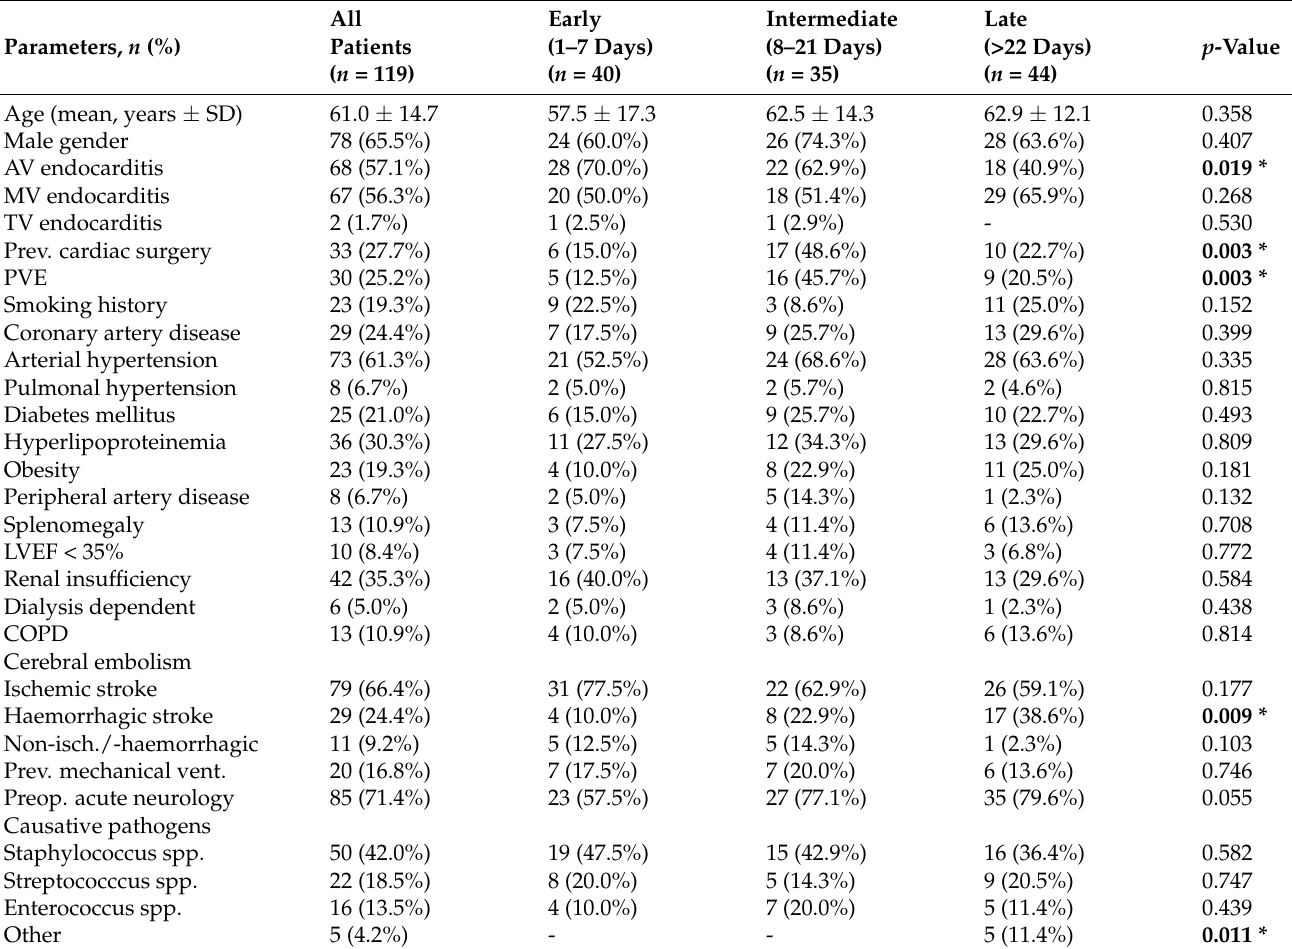
Table 1. Patient characteristics ( n = 119).